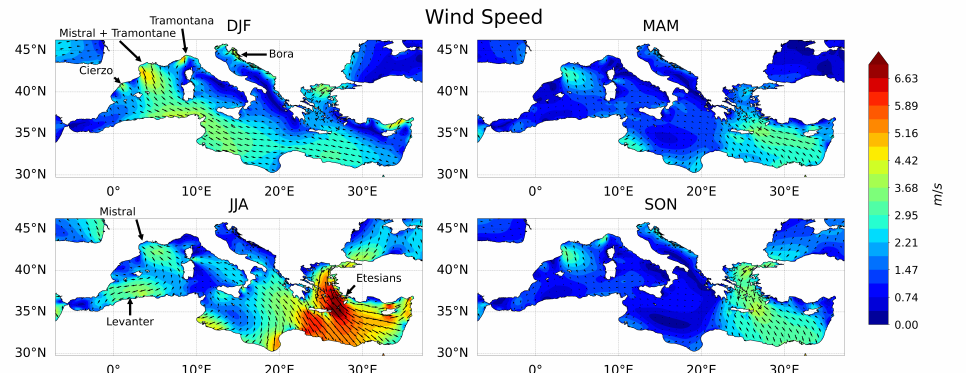
Figure 12. Seasonally averaged wind speeds and directions of the WRF/ORCHIDEE 10 m wind data. During the winter months, the Bora [62], Mistral and Tramontane [63,64], Tramontana [65], and Cierzo [66] winds can be observed. During the summer months, the summer Mistral [67], Levanter [65], and Etesian [68] winds can be observed.